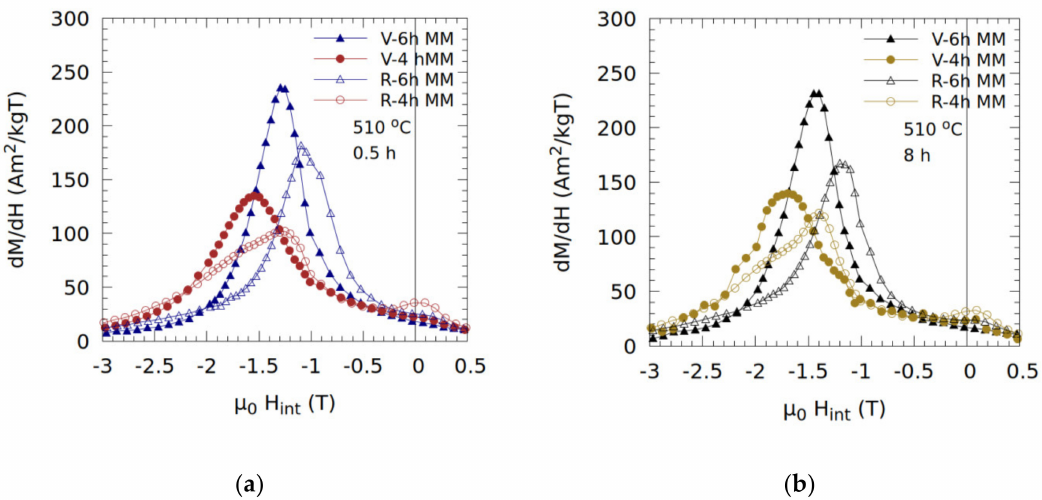
Figure 7. dM / dH vs. H plots for virgin (V) and recycled (R) samples milled for 4 or 6 h and annealed at 510 ◦ C ( a ) for 0.5 h and ( b ) 8